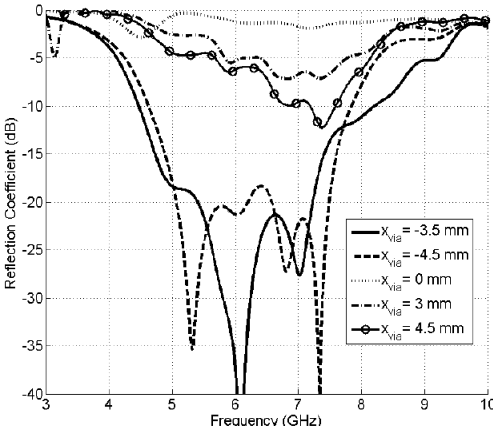
ffi cient (S11) with di ff erent via ( x